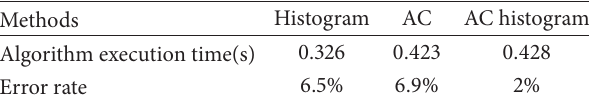
Table 9: Average execution times of different algorithms.